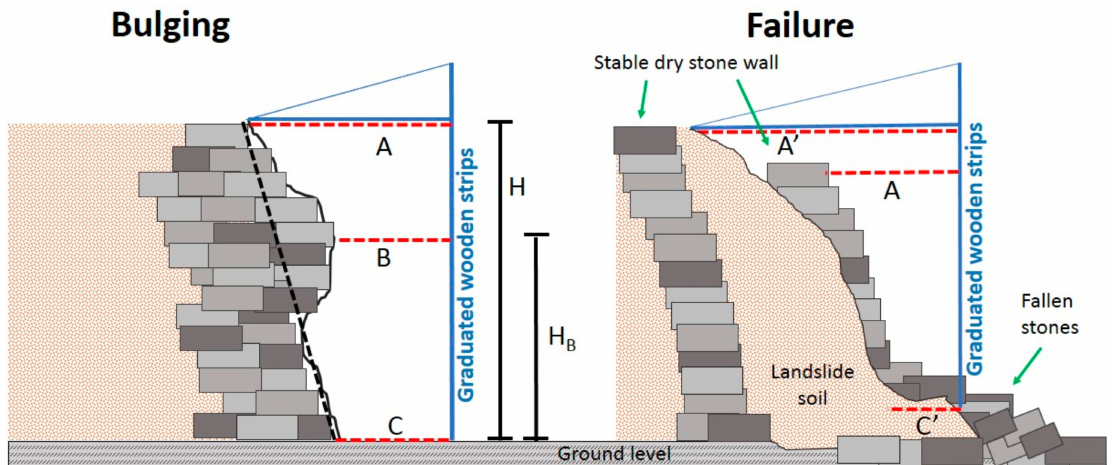
Figure 3. Measuring the amount of deformation for two examples of damage